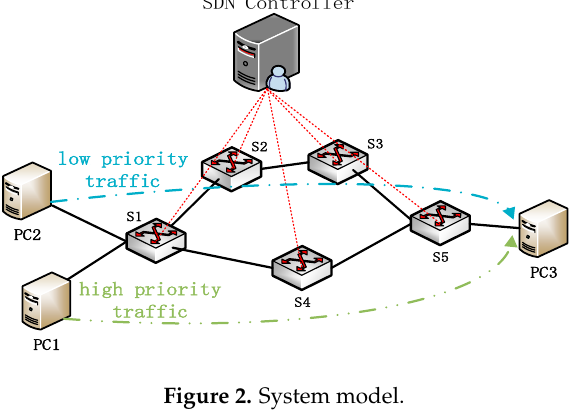
Figure 2. System model.